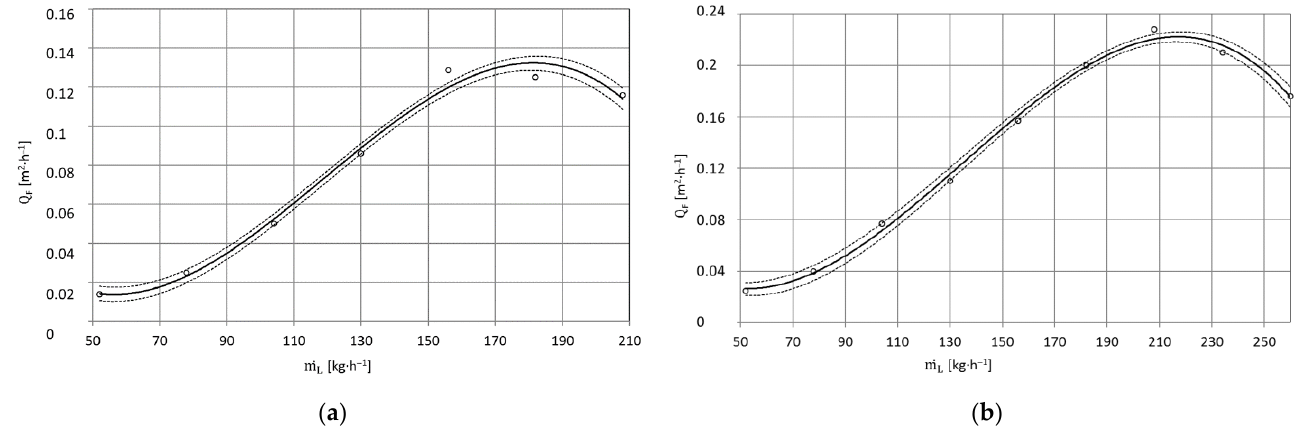
Figure 11. Influence of CO 2 ṁ L [kg·h  1 ] dry ice output on the maximum surface efficiency Q F . Figure 11. Influence of CO 2 m L [kg · h − 1 ] dry ice output on the maximum surface efficiency Q F [m 2 ·h  1 ] of paint stripping by high-pressure water-ice jet from X5CrNi18-10 steel surfaces (TS = 4 × [m 2 · h − 1 ] of paint stripping by high-pressure water-ice jet from X5CrNi18-10 steel surfaces (TS = 4 × 1.2mm, L k = 200 mm, l 2 = 250 mm, κ = 90°): ( a ) jet pressure p w = 20 MPa; ( b ) p w = 35 MPa. 1.2 mm, L k = 200 mm, l 2 = 250 mm, κ = 90 ◦ ): ( a ) jet pressure p w = 20 MPa; ( b ) p w = 35